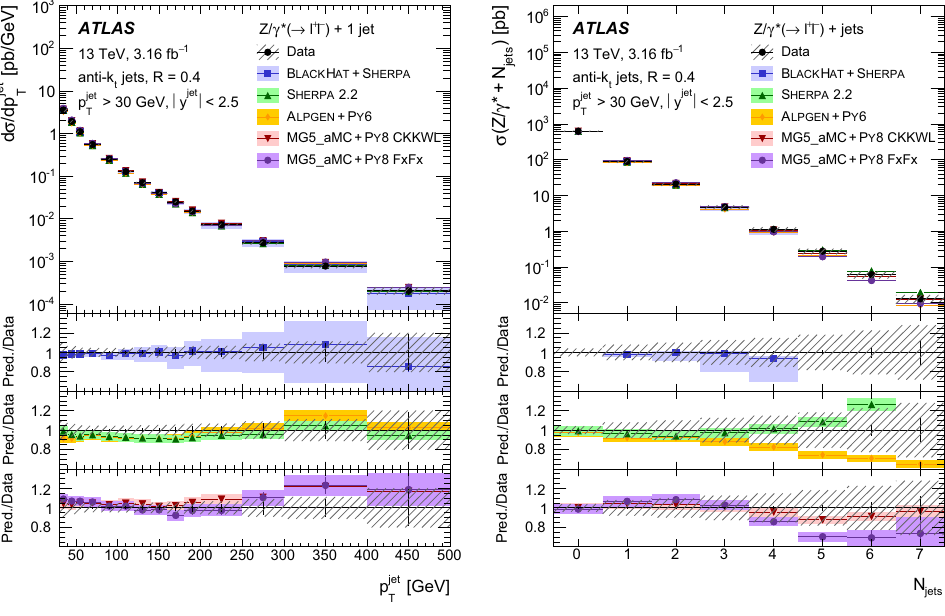
Fig. 6 Measured cross section as a function of jet p T for exclusive Z + 1 jet events ( left ) and exclusive jet multiplicity ( right ). The data are compared to the predictions from BlackHat+Sherpa , Sherpa 2.2 , Alpgen+Py6 , MG5_aMC+ Py8 CKKWL, and MG5_aMC+ Py8 FxFx.